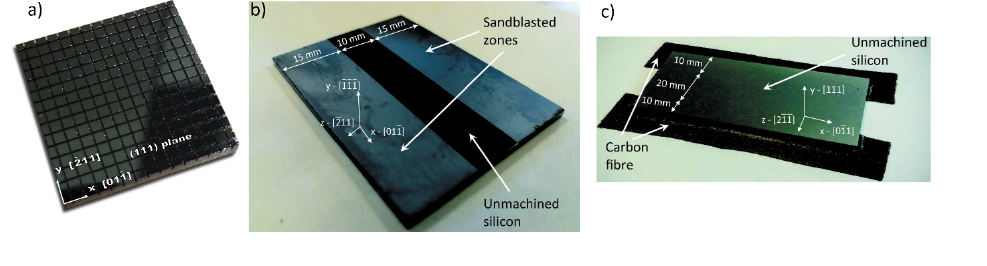
Figure 14. Silicon crystals bent using self-standing techniques: ( a ) grooving, ( b ) sandblasting, ( c ) carbon